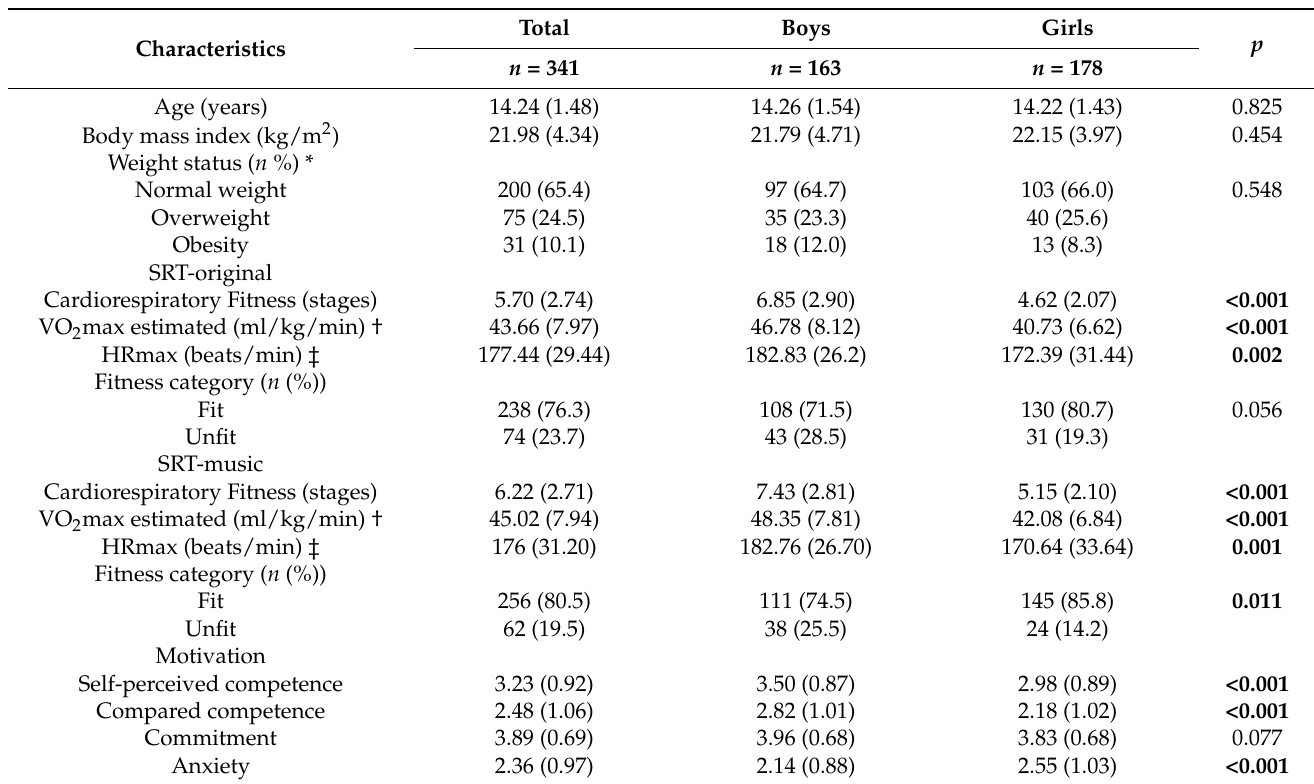
Table 1. Descriptive data of the participants.